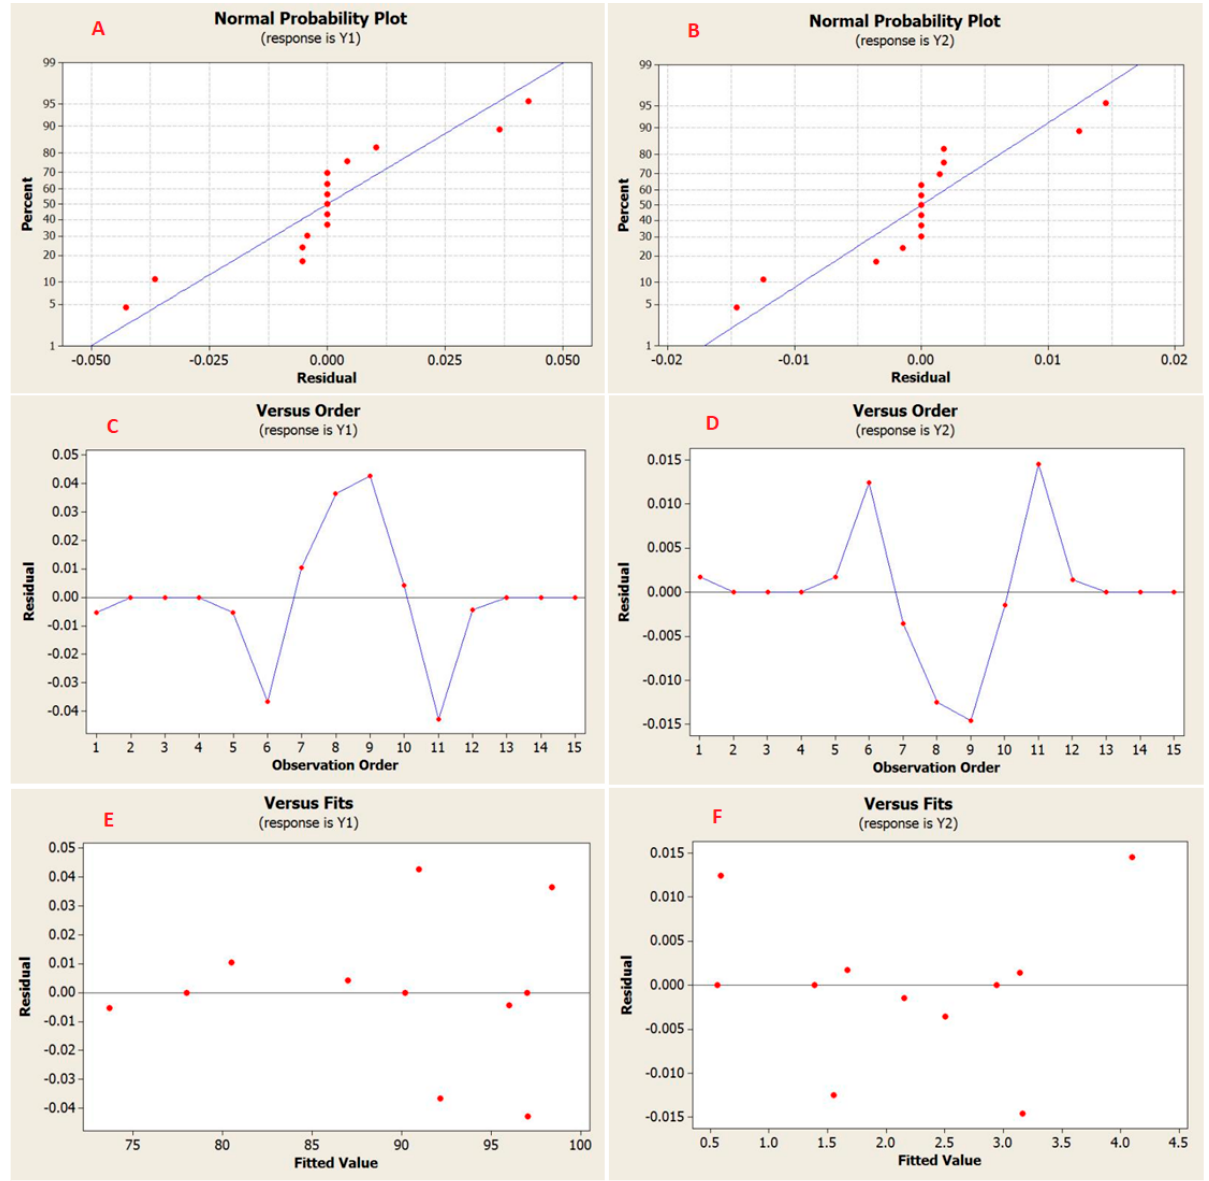
Figure 13. Normal probability plot of residuals for rejection ( A ) and permeate flux ( B ), Plot of residuals with data order for rejection ( C ) and permeate flux ( D ), and The residuals versus fitted values Plot for rejection ( E ) and permeate flux ( F ).